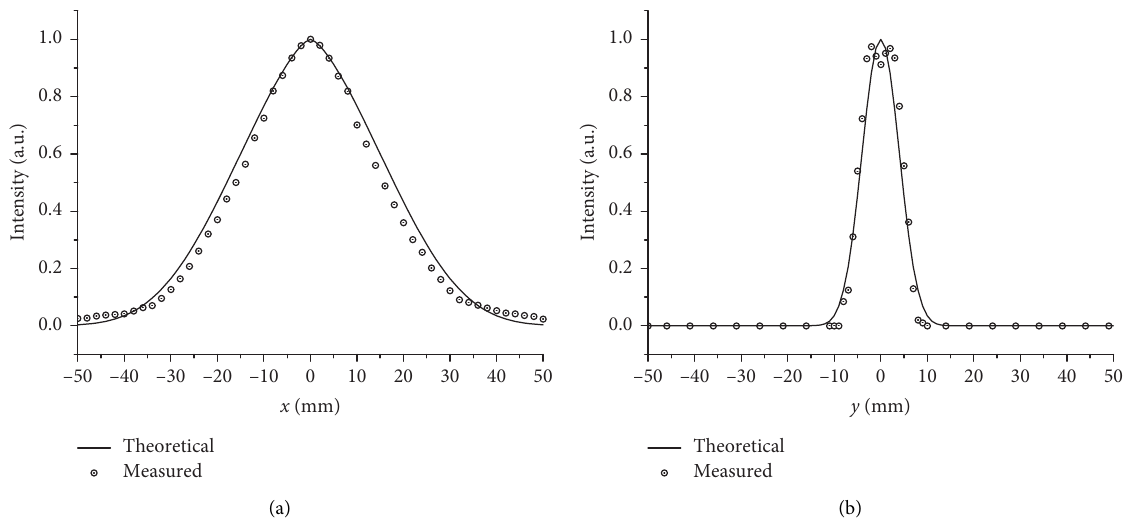
Figure 5: Measured and theoretical beam intensity profiles of HL63290HD. (a) x – z plane. (b) y – z